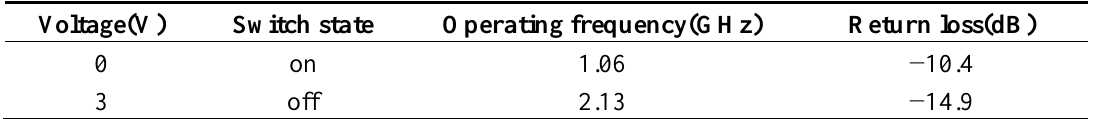
Table 1. Result of operating frequency and return loss of reconfigurable antenna in mobile device.